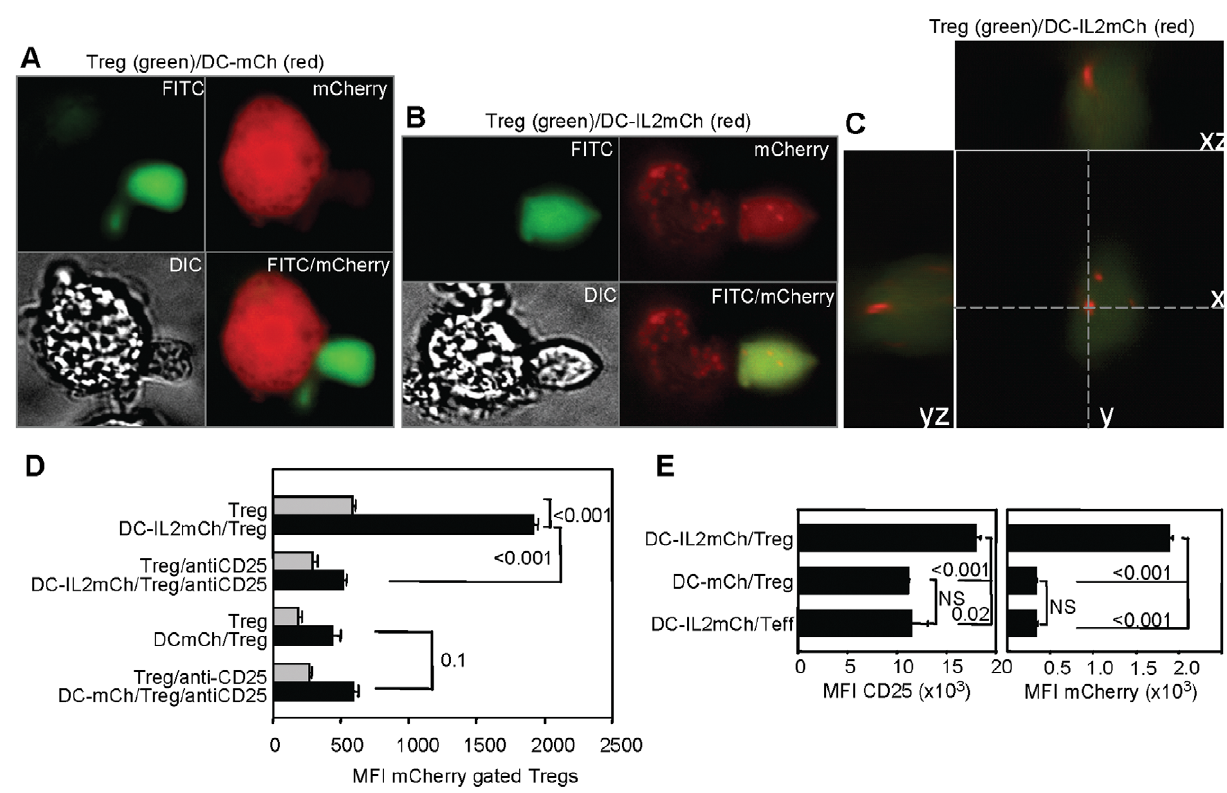
Figure 6. CD25 and cell contact dependent uptake of dendritic cell IL-2 by Treg cells. A–C: CFSE-labeled DO11.10 Tregs were stimulated with OVA peptide and different DC transfectants as in materials and methods. Panels show representative images of mCherry transfected dendritic cell (A) and IL-2mCherry transfected dendritic cell (B) in conjugate formation with Treg cell. Panels C: Three-dimensional rendering of a Treg cell localizes the IL-2mCherry to vesicles within Treg. D&E: DC-Treg contact facilitates IL-2mCherry transfer from DCs to Tregs that can be blocked by anti- CD25. DO11.10 CD4 + CD25 + Treg or CD4 + CD25 2 T effector (Teff) cells were cultured in triplicate in upper chambers of transwells separated from (grey bars) or in lower chambers of transwells in contact with (black bars) BMDCs from IL-2 2 / 2 B6 mice that were transfected with IL-2mCherry (DC- IL2mCh) or control mCherry (DCmCh) and analyzed by flow cytometry as in materials and methods. Indicated cultures contained anti-CD25 antibody (antiCD25). D: Bars are the mCherry MFI means 6 SE of gated Thy1.2high cells from triplicate lower chambers (black) and upper chambers (gray). E: Bars are the CD25 (left panel) and mCherry (right panel) MFI means 6 SE of gated Thy1.2high cells from triplicate lower chambers (black). Statistical analysis was performed by paired t -test for within well samples and by student t-test for between well samples. Experiment was performed three times yielding similar results, representative experiments are shown.